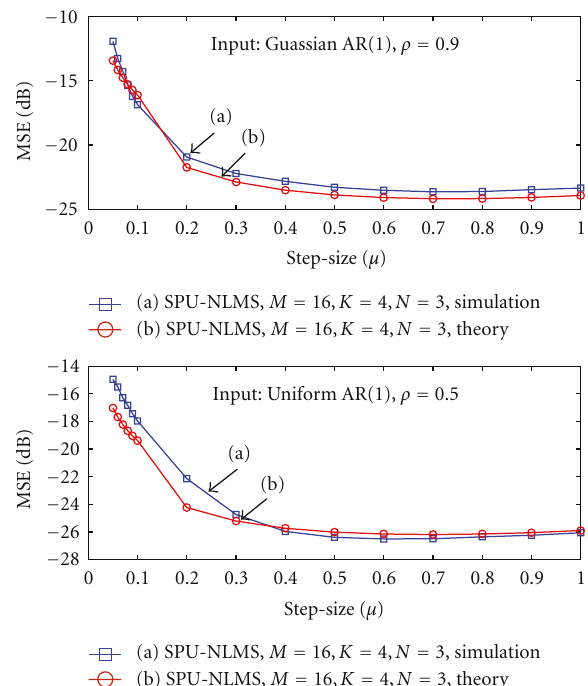
Figure 16: Steady-state MSE of SPU-NLMS with M = 16, K = 4, and N = 3 as a function of the step size in nonstationary environment for di ff erent input signals.